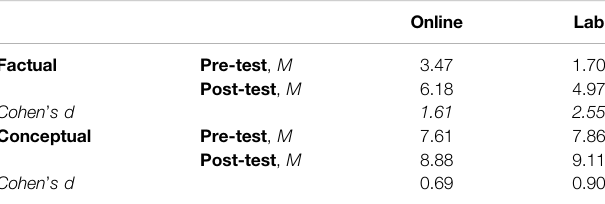
TABLE 2 | Mean scores from a 20 item multiple-choice test (10 factual and 10 conceptual questions). The lab study shows larger effect sizes for pre-to post score, yet with same trend.